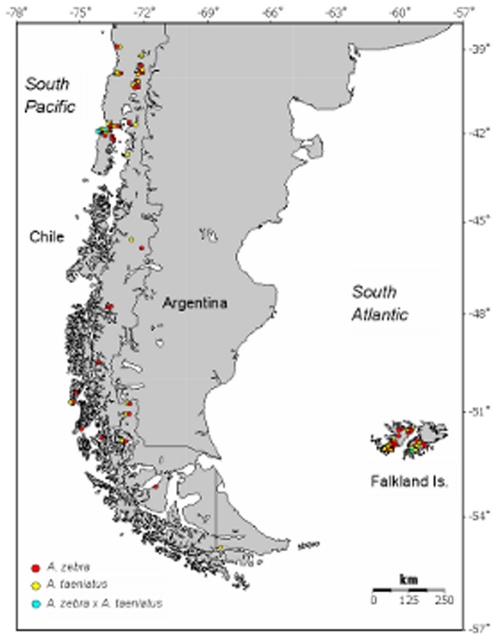
Accepted distribution of the genus Aplochiton in Chilean Patagonia and the Falkland Islands, based on data published in [16], [17] (represented by circles) and samples collected during the present study (represented by squares).